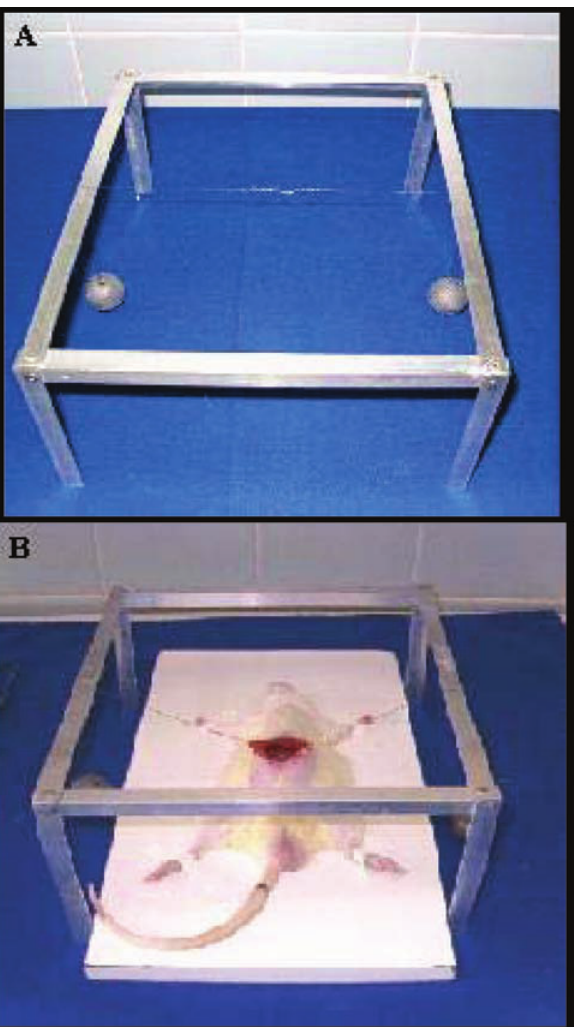
FIGURE 1 - Aluminum frame used for the PC exposition of small animals submitted to